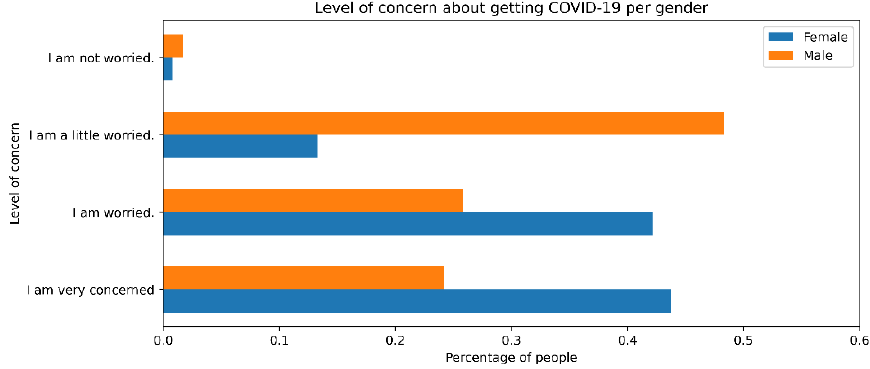
Figure 4. How worried are you about getting COVID-19 (by gender).